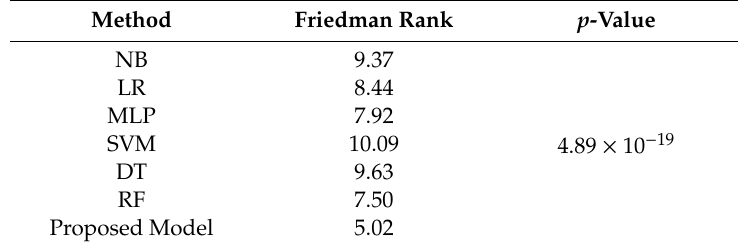
Table 9. Friedman test results by utilizing the value of accuracy for all datasets.